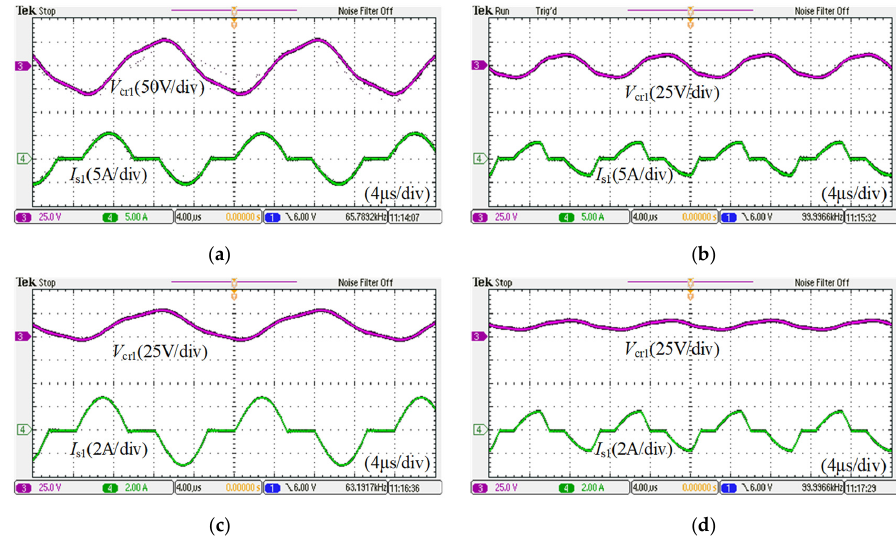
Figure 17. ZCS experimental verification waveform. ( a ) Full ‐ bridge FM mode; ( b ) full ‐ bridge phase ‐ shift mode; ( c ) half ‐ bridge FM mode; ( d ) half ‐ bridge phase ‐ shift mode.